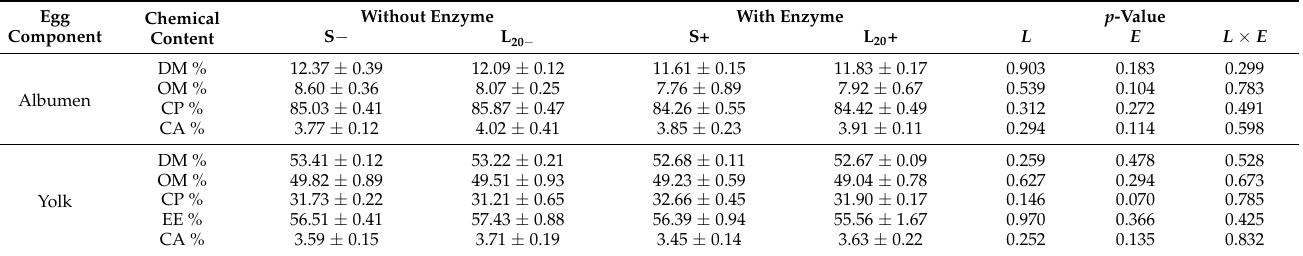
Table 7. Influence of enzymes addition in lupine-based diets on the chemical composition of quail eggs (% of